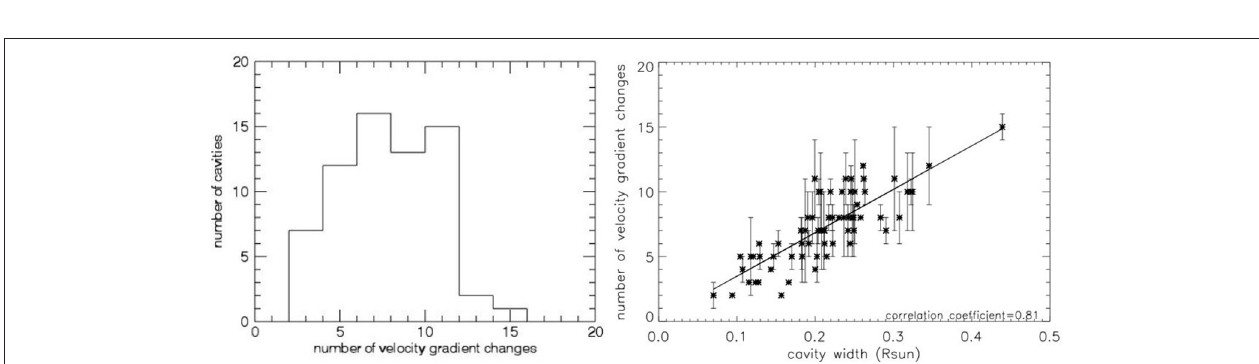
FIGURE 7 | Left: Histogram of number of velocity gradient changes. Right: Cavity width vs. number of velocity gradient changes. Correlation coefficient is equal to 0.81.